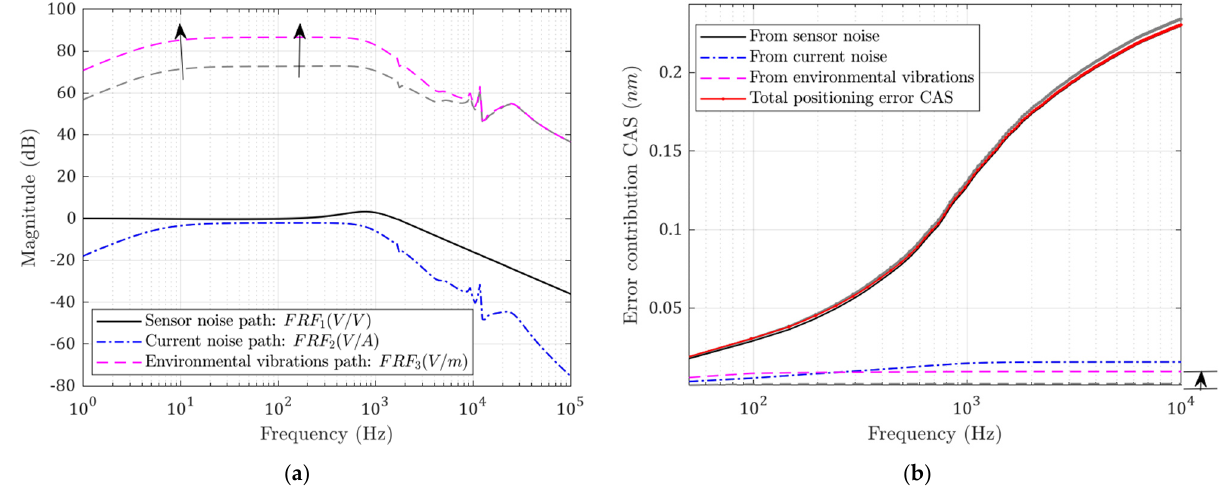
Figure 12. ( a ) Noise transfer functions; ( b ) CAS plots for each error source. Performance with increased flexure stiffness k 2 (grey: before; colored: after).